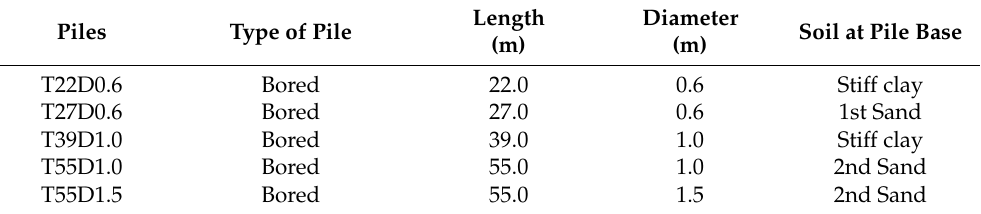
Table 1. Model pile dimensions and soil at pile